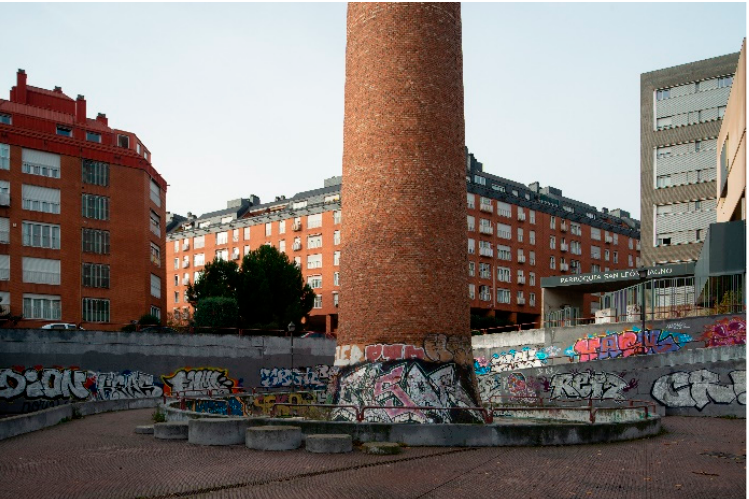
Figure 7. Image by Davide Curatola Soprana from Urban Reports for TRAHERE. It intends to show the state of abandonment, squatting, and (at the same time) the potential of this urban space.